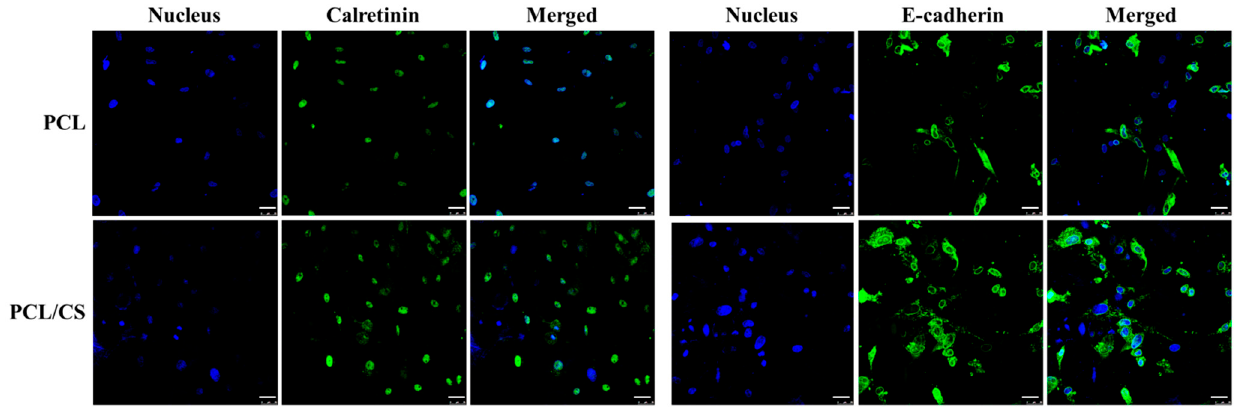
Figure 7. The relative gene expression level of calretinin, E-cadherin, intercellular adhesion mole- cule (ICAM-1) and vascular endothelial factor (VEGF) by mesothelial cells was determined by quantitative real-time polymerase chain reaction (qRT-PCR) after culture for 7 days in PCL and PCL/CS nanofiber membranes. Glyceraldehyde 3-phosphate dehydrogenase (GAPDH) was used for the quantification. * p < 0.05 compared with PCL.